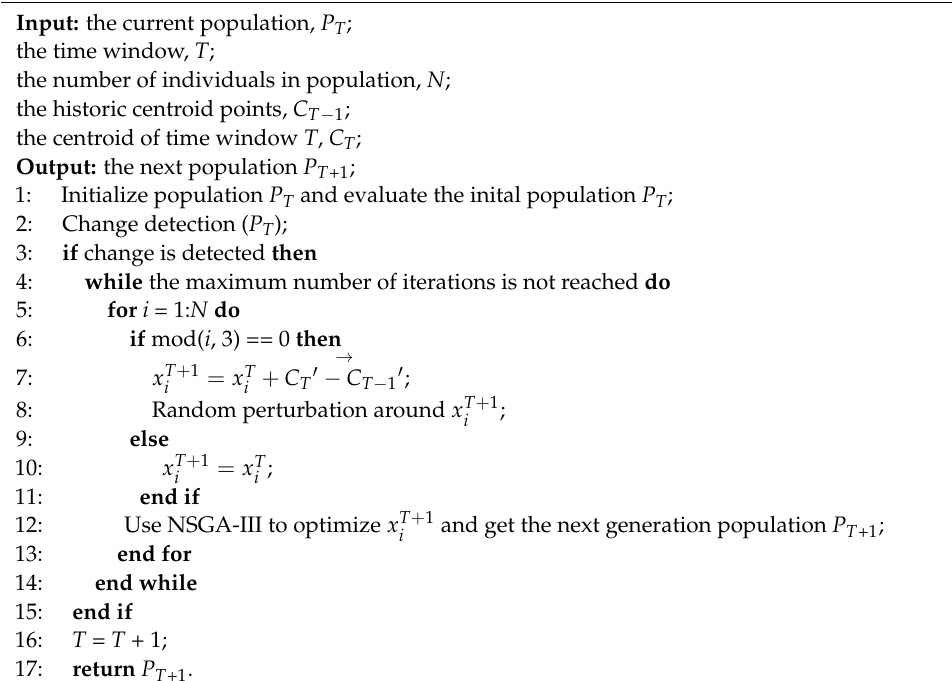
Algorithm 4 Second-order random strategy combined with